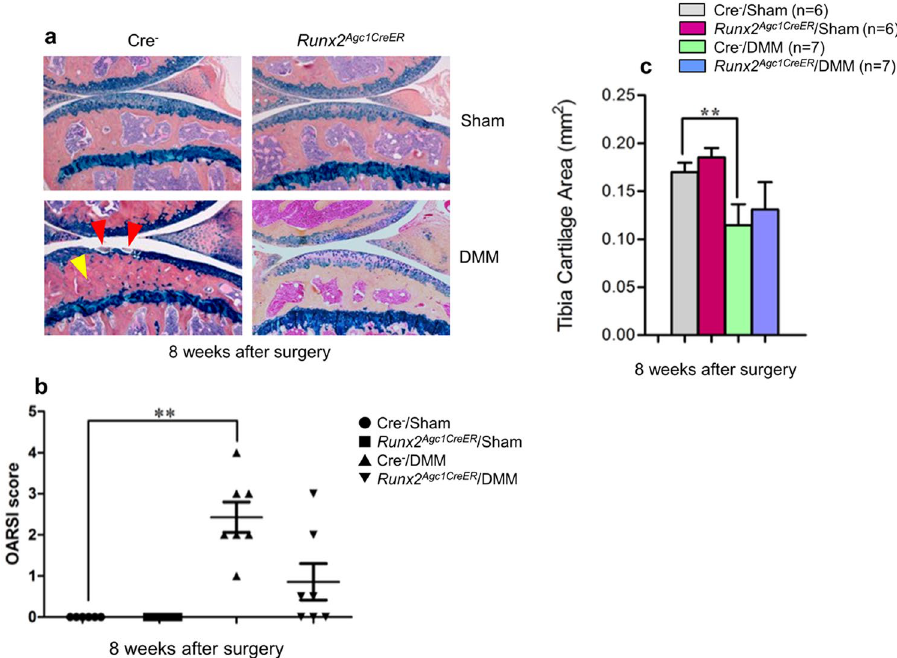
Figure 2. OA progression was decelerated in Runx2 Agc1CreER mice 8 weeks after DMM surgery. Tamoxifen was administered into 8-week-old male Cre-negative control and Runx2 Agc1CreER KO mice (1 mg/10 g body weight, i. p. injection, daily for 5 days). DMM surgery or Sham operation was performed when these mice were 12-week-old (right hind limbs). ( a ) Knee joints were harvested from Cre-negative and Runx2 Agc1CreER KO mice 8 weeks post- surgery and Alcian blue/Hematoxylin Orange G staining was performed. Histological results showed that articular cartilage degradation (red arrowheads) and subchondral sclerosis (yellow arrowhead) were observed in Cre- negative control mice after DMM surgery. In contrast, defects in articular cartilage degradation and subchondral sclerosis induced by DMM surgery was significantly protected in Runx2 Agc1CreER KO mice. ( b , c ) Histological sections were analyzed by OARSI scoring system and by histomorphometric method. The severity of OA-like phenotype was analyzed by grading histological sections using OARSI score system by two blinded observers. Articular cartilage area of tibia plateau was quantified by tracing the Alcian blue-positive staining areas using the OsteoMeasure system. These results demonstrated that DMM surgery caused significant OA-like defects in Cre- negative control mice. However, no significant difference, rather a decreased tendency of cartilage degeneration was observed in the mice 8-weeks after DMM surgery in Runx2 Agc1CreER KO mice compared to Cre-negative control mice. ( ** P < 0.01, one-way ANOVA followed by Tukey’s post-hoc test; n = 6–7 mice per